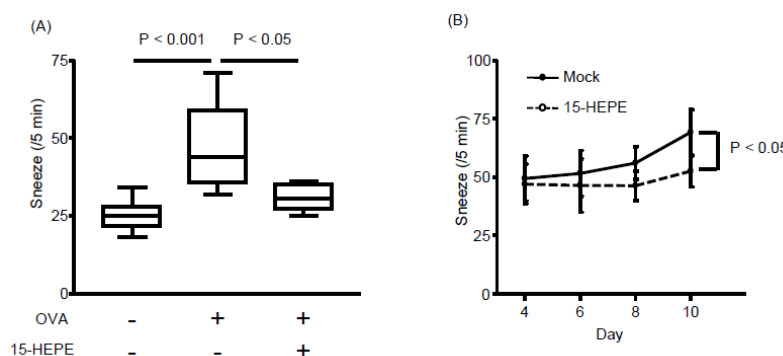
Figure 4. Nasal administration of 15-HEPE dampens allergic rhinitis. ( A ) Mice were nasally treated with 15-HEPE or vehicle (0.5% EtOH) before challenge in an allergic rhinitis model. Sneezing rates were calculated. Data are from two independent experiments ( n = 8–10). Center values indicate medians. Statistical significance was calculated by using one-way ANOVA followed by Dunn’s Kruskal–Wallis Multiple Comparisons. ( B ) Allergic rhinitis was induced in mice during days 1 through 4. From day 5 through 10, 15-HEPE or mock treatment (0.5% EtOH PBS) was nasally administered 5 min before OVA challenge. Then the sneezing rate was calculated on days 4 through 10. Data are from three independent experiments ( n = 11 or 12). Data are expressed as the mean ± SEM. Statistical significance was calculated by using the Mann–Whitney U test.